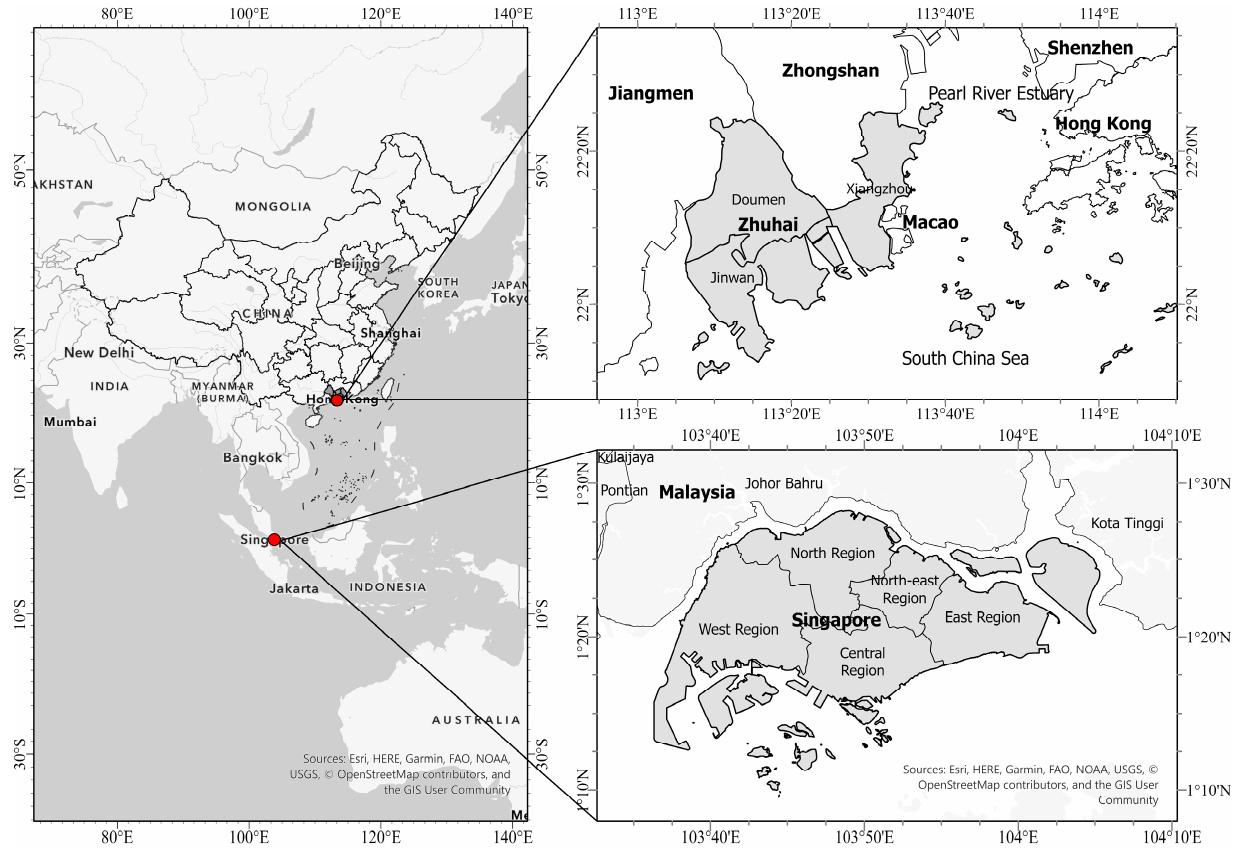
Figure 1. Geographic locations of study